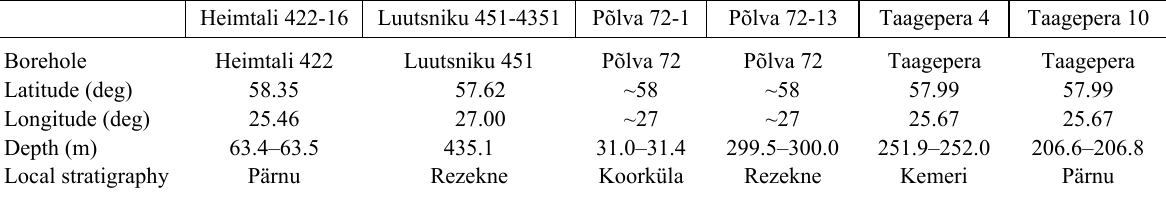
Fig. 1. Location of the Lemme sample site on the southwestern coast of Estonia. Table 1. Samples from Devonian sandstone, location, depth and